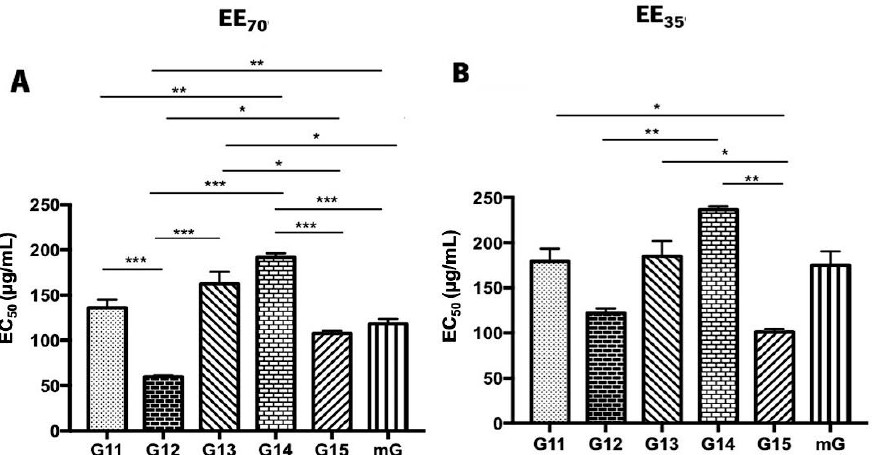
Figure 4. Superoxide anion scavenging activity of propolis hydroalcoholic extracts from Gerês. Propolis hydroalcoholic extracts have ethanol 70% (v/v) (EE 70 ) or 35% (EE 35 ). Results are expressed in EC 50 (µg/mL) as mean ± SEM. (* 0.05 > p ≥ 0.01, ** 0.01 > p ≥ 0.001, *** p < 0.001) (G: Gerês; mG: a mixture of propolis samples).